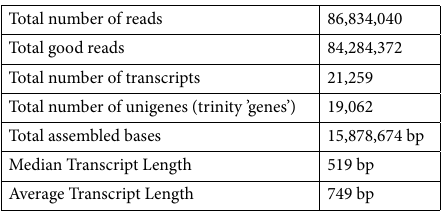
Table 1. Summary of the pararama integument